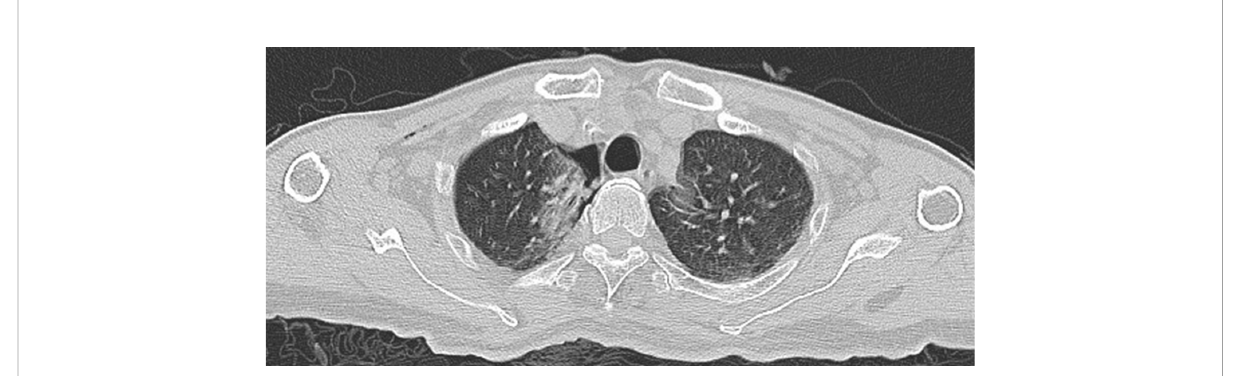
FIGURE 10 Post-ablation scan: The lesion was achieved complete ablationthe: post-ablation ground-glass opacity around the post-ablation target zone should be at least 5 mm greater than the boundary of the gross tumor region.